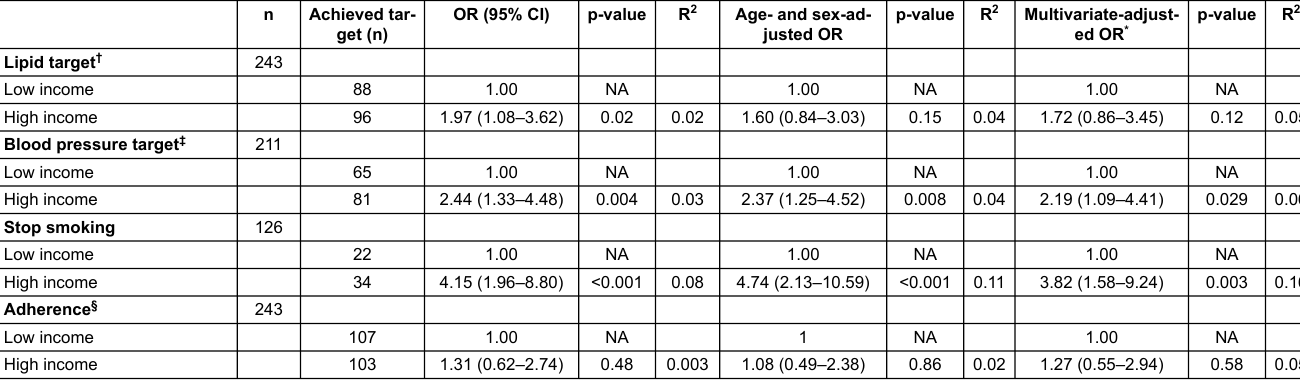
n Achieved tar- OR (95% CI) p-value R 2 Age- and sex-ad- get (n)